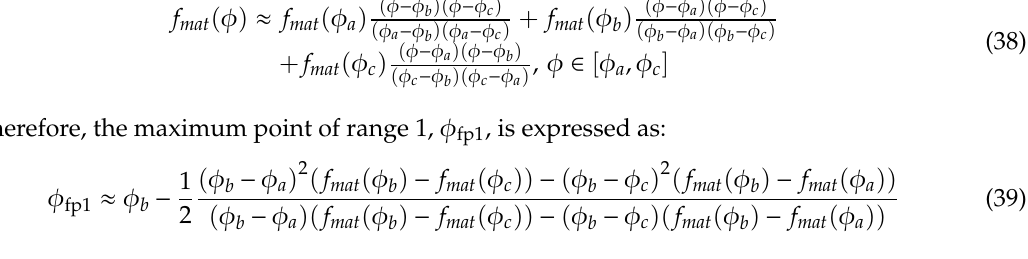
Figure 6. f mat versus ϕ in the interval [−90°, 90°].